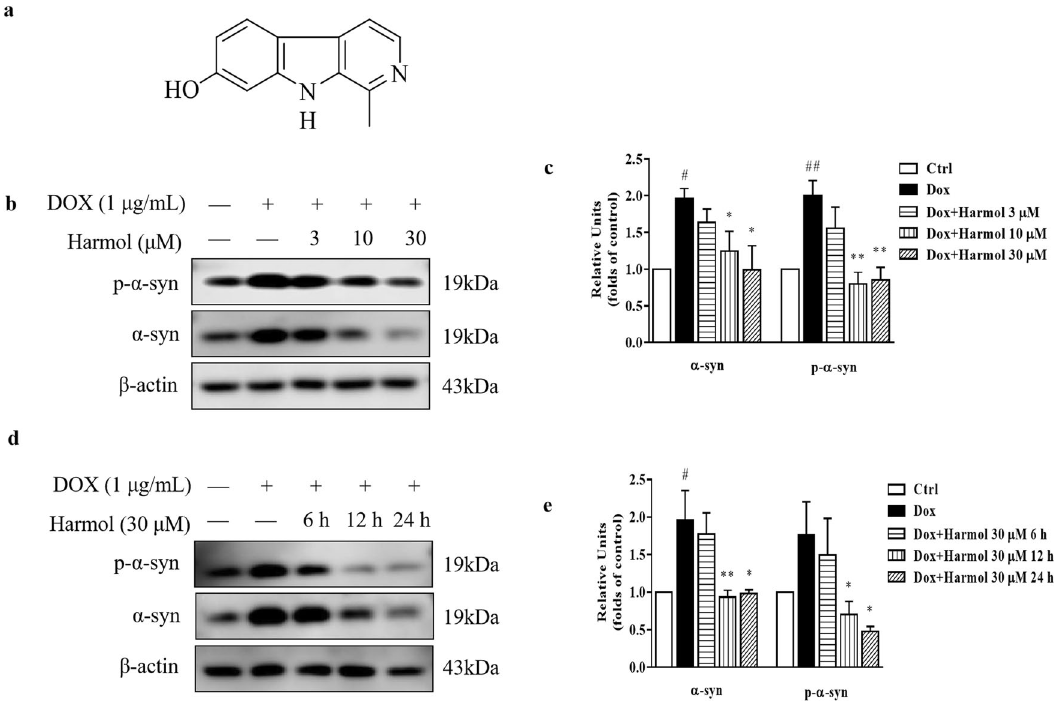
Fig. 1 Harmol degrades the α -syn. a Chemical structure of harmol. b Tet-on inducible PC12 cells were treated with 1 µg/mL DOX for 24 h, then 3, 10, and 30 µM harmol were added for 24 h. The expression of p- α -syn and α -syn were determined by western blot. Representative blots are shown. c Relative intensity was normalized to that of β -actin. Data are presented as the mean ± SEM from three independent experiments. # P < 0.05 and ## P < 0.01 vs. the control (0.1% DMSO). * P < 0.05 and ** P < 0.01 vs. the DOX. d After induction with DOX for 24 h, PC12 inducible cells were incubated with harmol (30 µM) for 6 h, 12 h, and 24 h. The expression of p- α -syn and α -syn were determined by western blot. Representative blots are shown. e Relative intensity was normalized to that of β -actin. Data are presented as the mean ± SEM from three independent experiments. # P < 0.05 vs. the control (0.1% DMSO). * P < 0.05 and ** P < 0.01 vs. the